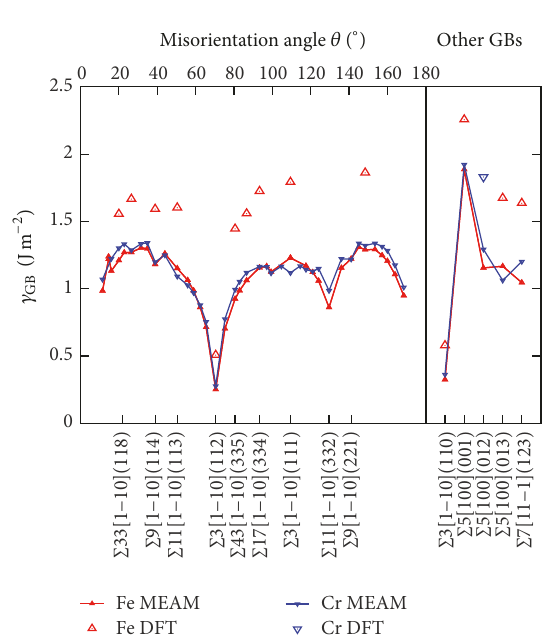
Figure 3: GB energies for different GBs with a [110] rotation axis (left) and selected other GBs (right) from 2NN-MEAM simulations (connectedlines)andDFTcalculations(unconnectedsymbols).The downwardpointingtrianglesdenoteresultsforCr(thisstudy),while the upward pointing triangles stand for Fe results from